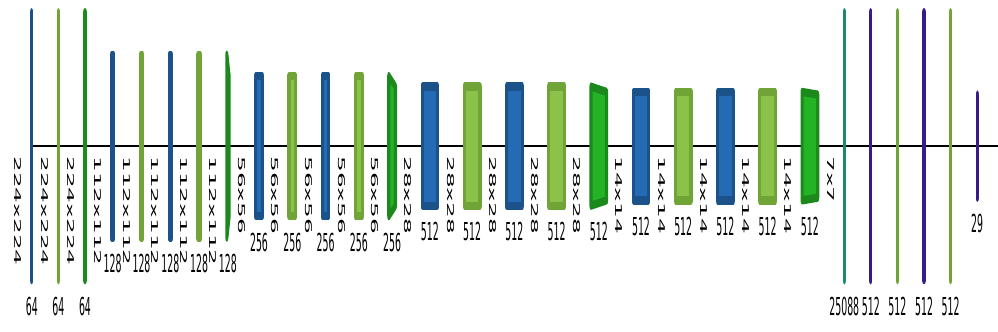
Figure 6. Proposed deep convolutional network visualization. The color-coded boxes represent the layers in the model. Convolutional layers are blue ( ), batch normalization layers are lime ( ) and max-pooling layers are forest green ( ); these are followed by a flatten layer, shown in emerald green ( ), a fully connected layer in violet ( ) and the Softmax output in magenta ( ). The number of dimensions in each layer is shown beside/below that layer.